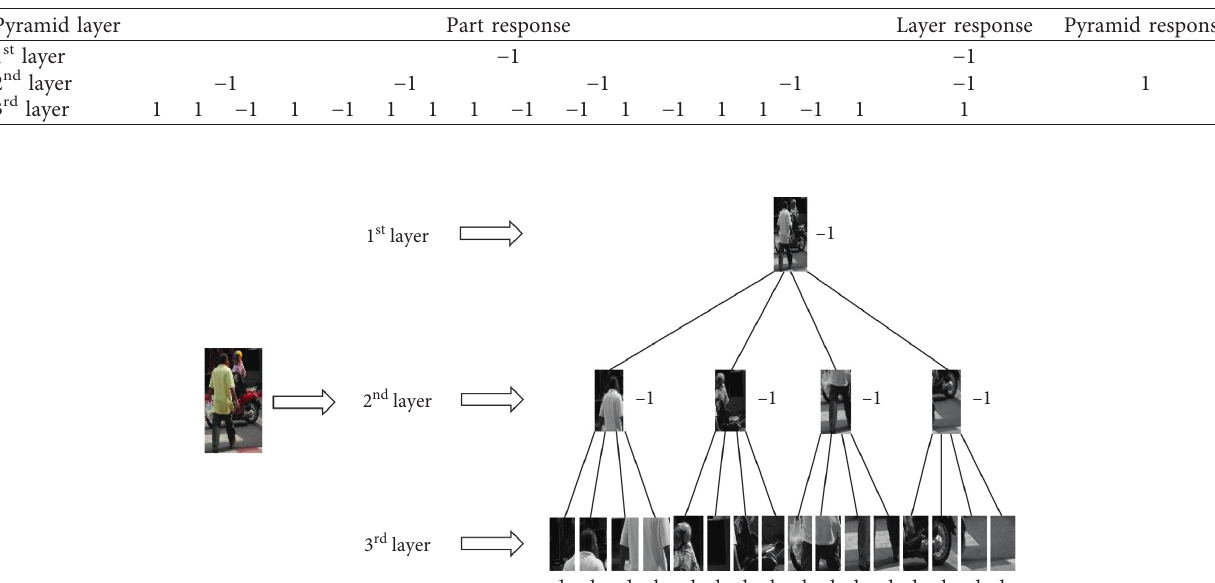
Table 1: Examples of results for the pyramidal ensemble classifier.